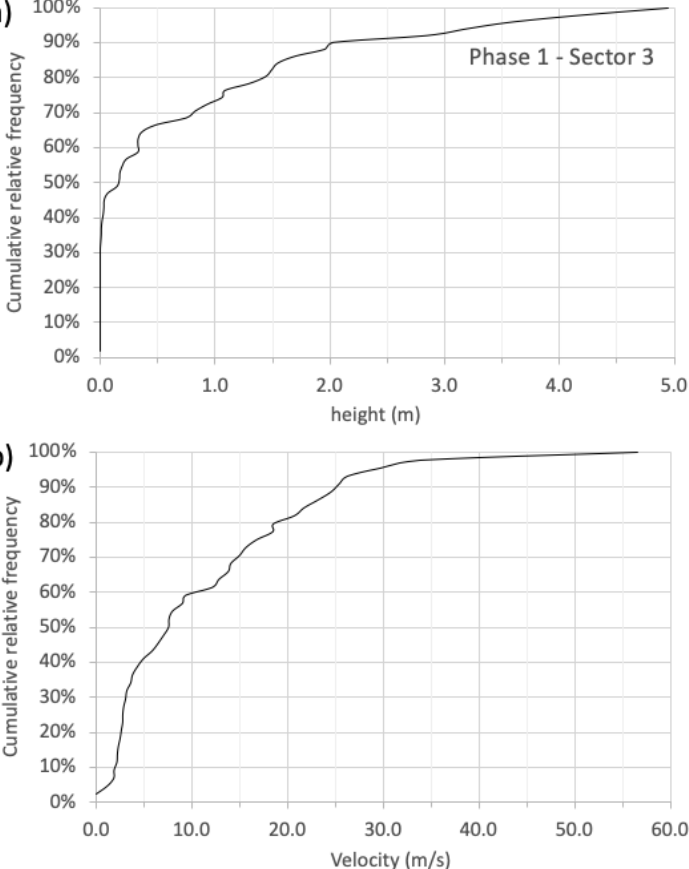
Figure 10. Cumulative relative frequency of heights ( a ) and velocities ( b ) for Phase 1 trajectories reaching Sector 3.